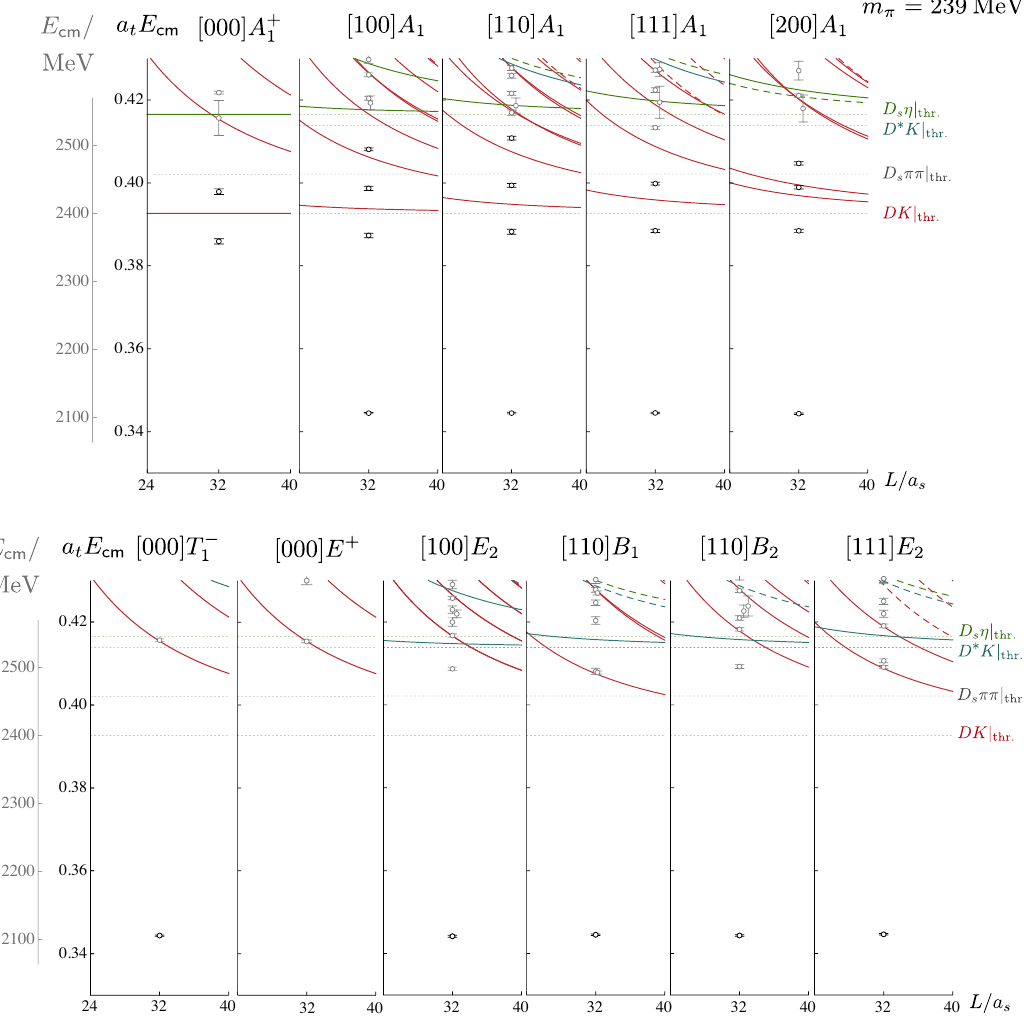
Figure 3 . DK I = 0 finite-volume spectra on the m π = 239 MeV ensemble labelled by [ ~P ]Λ ( P ) . Points show the extracted finite-volume energy levels transformed to the centre-of-momentum frame; black points are used in the scattering analysis whilst grey points are not. Dotted lines show relevant kinematic thresholds. Solid lines/curves show non-interacting energies with dashed curves indicating non-interacting energies where the corresponding operator was not included in the